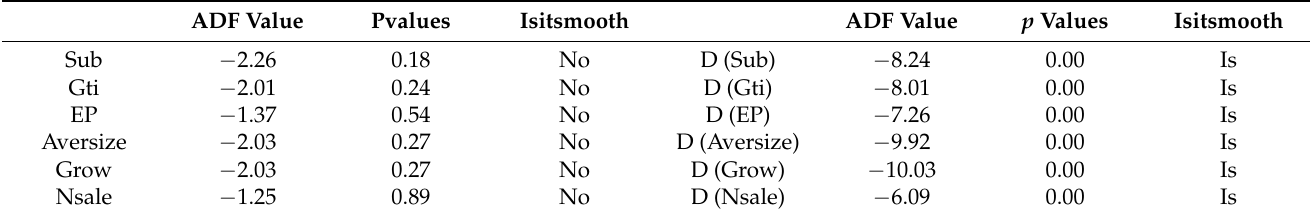
Table 3. Results of stability of variables.